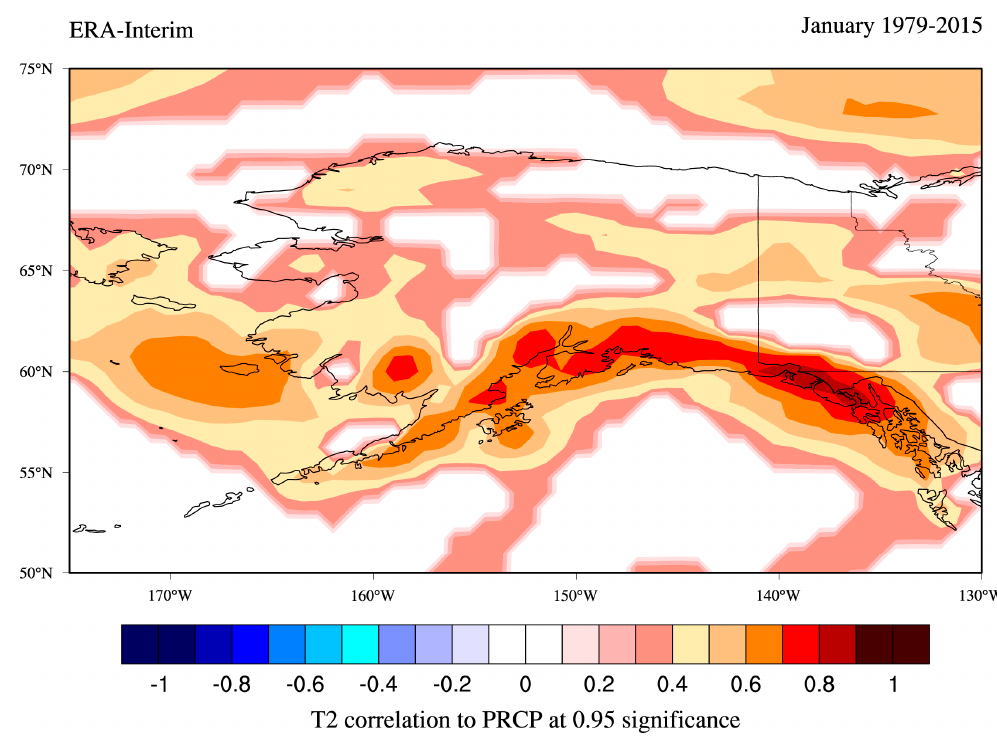
Figure 5. Correlation between precipitation and the 2-meter mean temperature (°C) for the Alaska region for the month of July as derived from the ERA-Interim reanalysis, 1979–2015 [21].